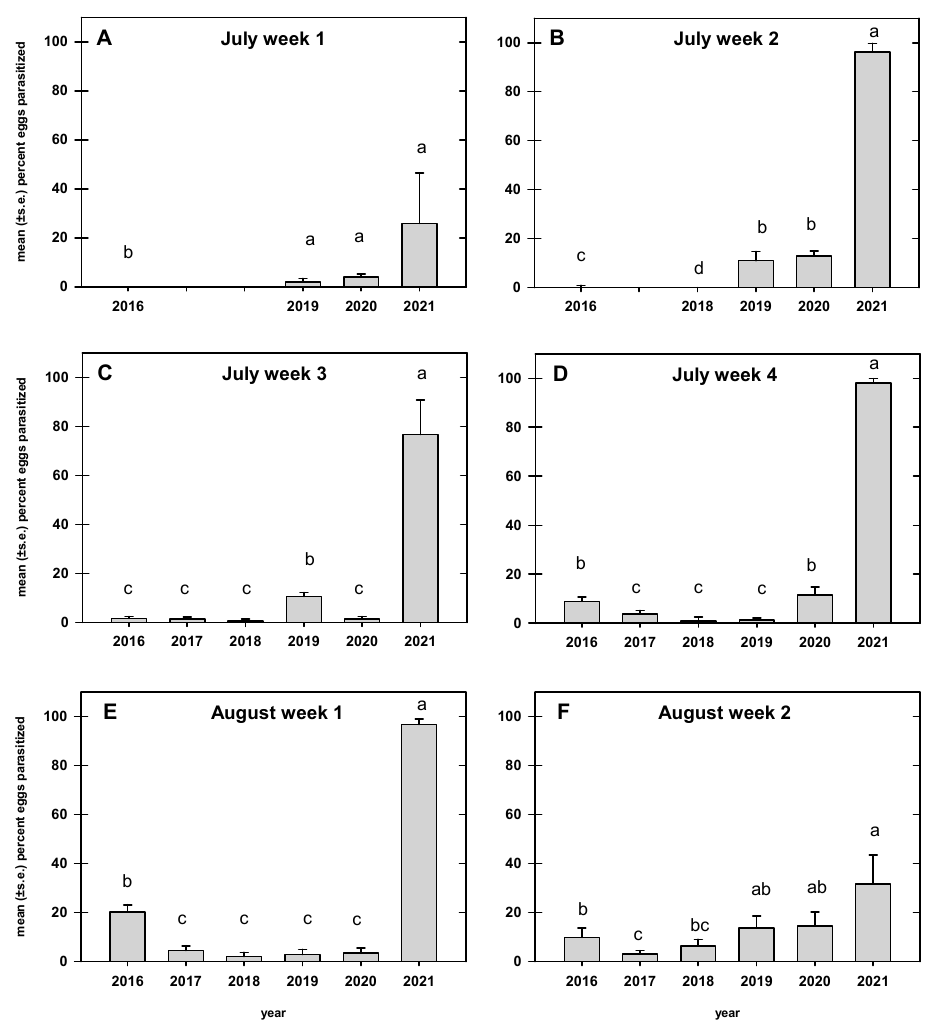
Figure 3. Mean (+s.e.) percent parasitism for each week compared by year, Beltsville, Maryland, USA. For each week, years followed by the same letters were not significantly different (ANOVA: experiment-wise adjusted p ≤ 0.05).